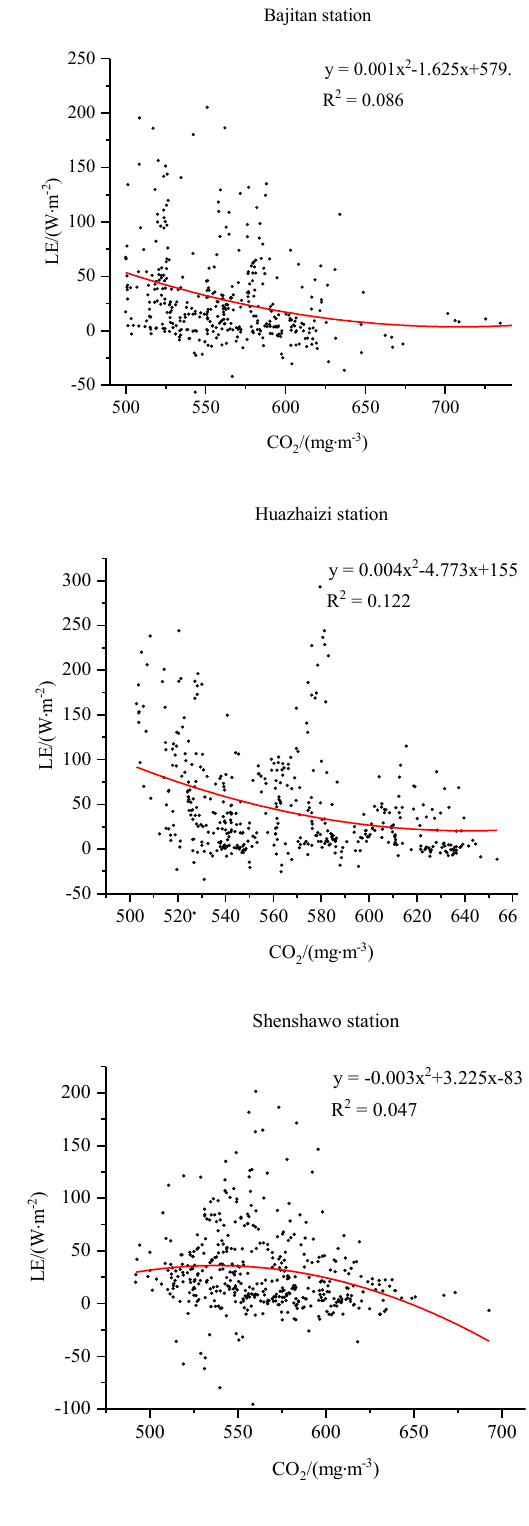
Figure 8. Regression analysis curves of LE and influencing factors under different underlying surface types.